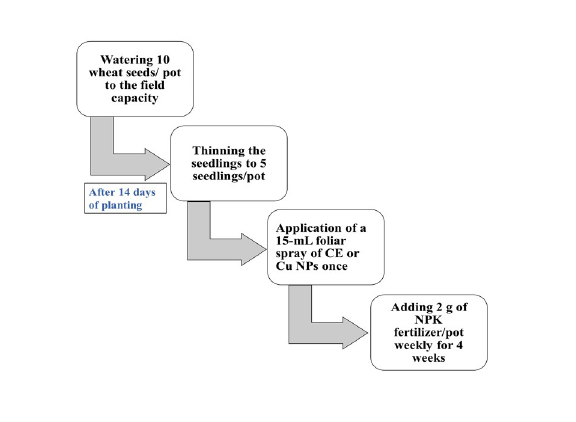
Fig 2. Schematic outline of the pot cultivation. Physical and chemical characteristics of the soil used in this study as well as the procedure used for Chlorophyll extraction and estimation of chlorophyll a, b and total chlorophyll contents were previously reported by Essa et al. [20].